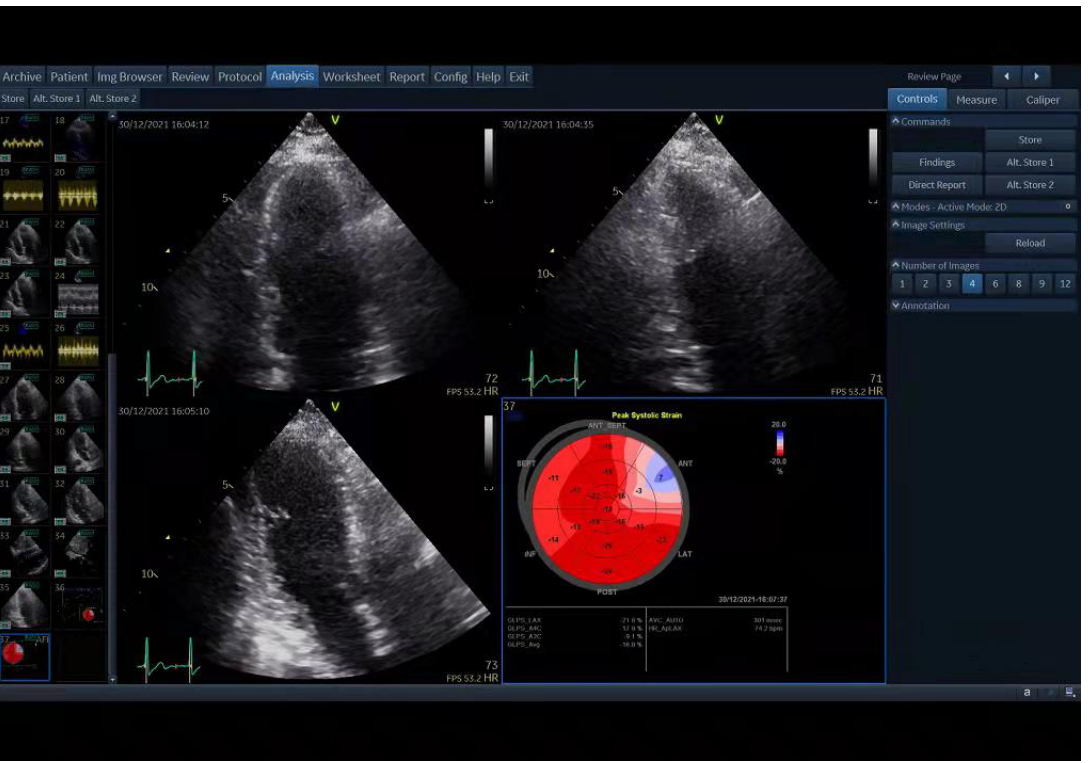
Figure 1. Two-dimensional speckle-tracking echocardiography (2D STE) analysis shows the result of global longitudinal strain (GLS) on a bull’s -eye depiction acquired by